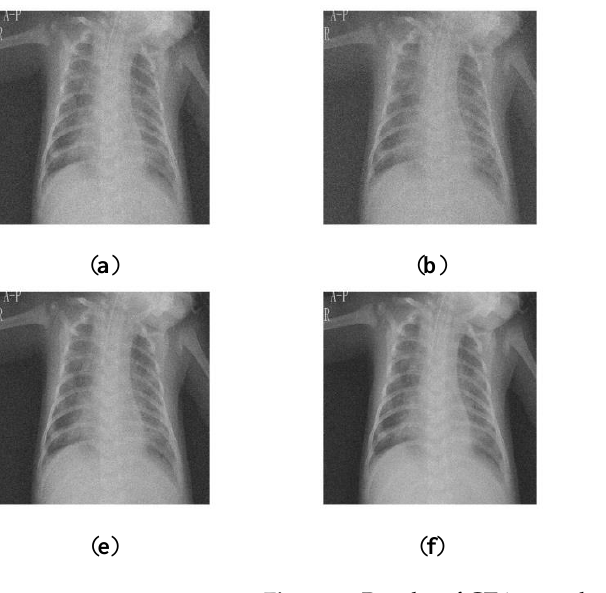
Figure 9. Results of CT image denoising, ( a ) Outcomes of Mingliang et al., 2016 [5]; ( b ) outcomes of Kuppusamy et al., 2019 [7]; ( c ) outcomes of Cheng et al., 2019 [10]; ( d ) outcomes of Zhao et al., 2019 [11]; ( e ) outcomes of Jomaa et al., 2018 [13]; ( f ) outcomes of Manoj and Singh, 2020 [14]; ( g ) outcomes of proposed method.